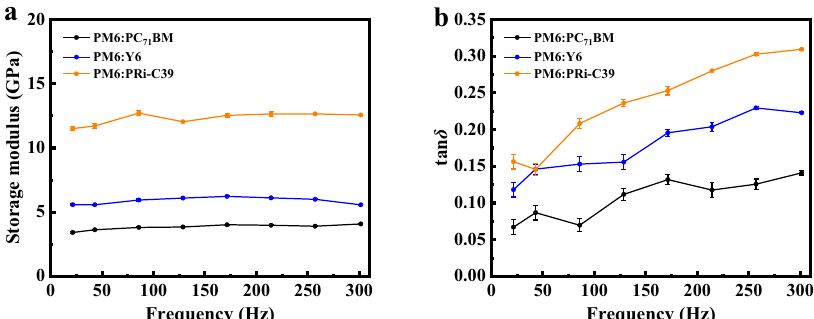
Fig. 4 Nano-DMA test results of the BHJ fi lms. The behavior of a storage modulus and b tan δ as a function of loading frequency for various blend fi lms. Data are presented as mean ±